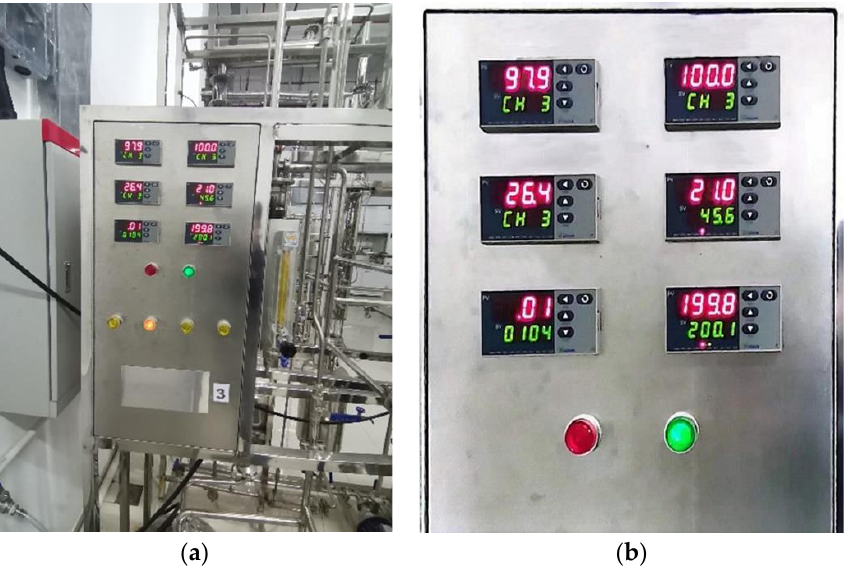
Figure 1. Experimental test device and recording equipment. ( a ) Sieve tray distillation column; ( b ) display panel and run parameters. Table 1. The geometrical parameters of the sieve tray distillation columns and operational parameters.